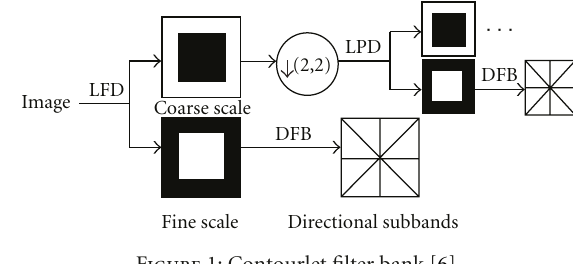
Figure 1: Contourlet filter bank [6].